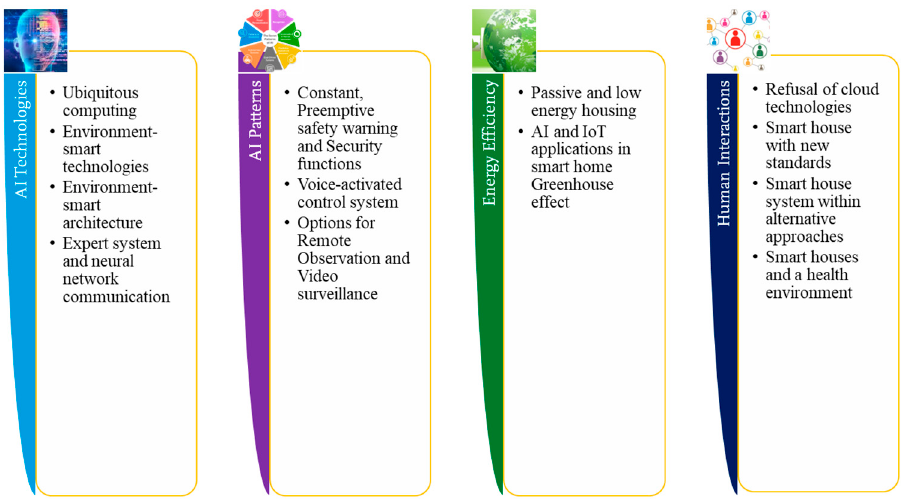
Figure 10. The framework of AI applications in the design of smart buildings .